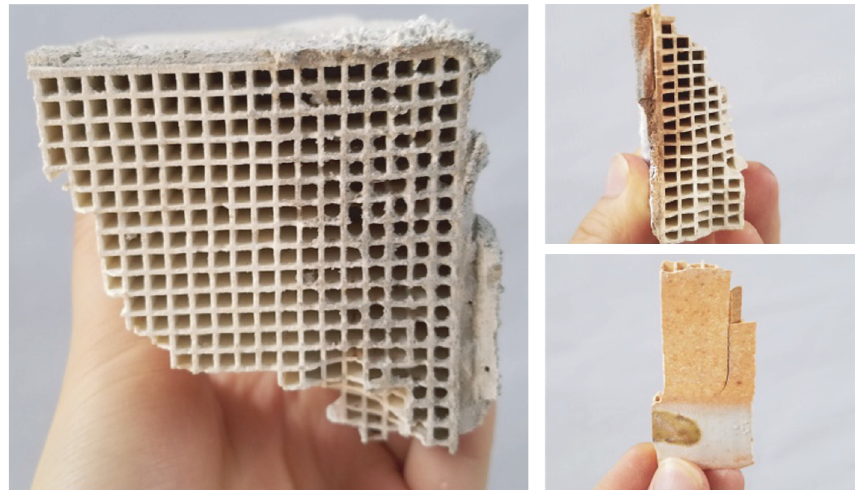
Figure 7: Effect picture of ceramics after heating.